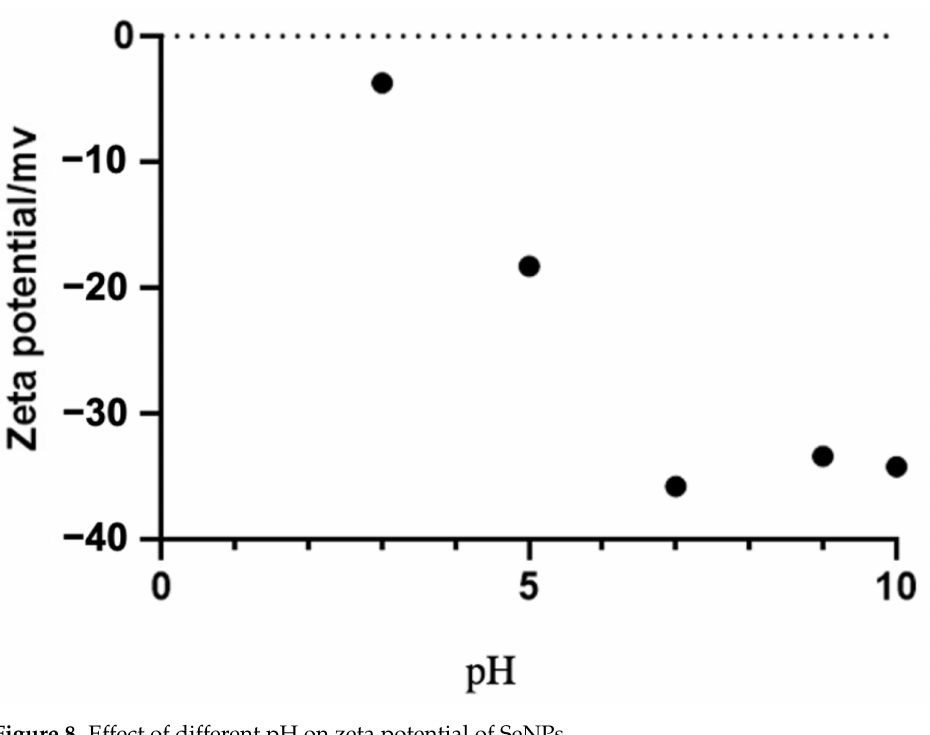
Figure 8. Effect of different pH on zeta potential of SeNPs.